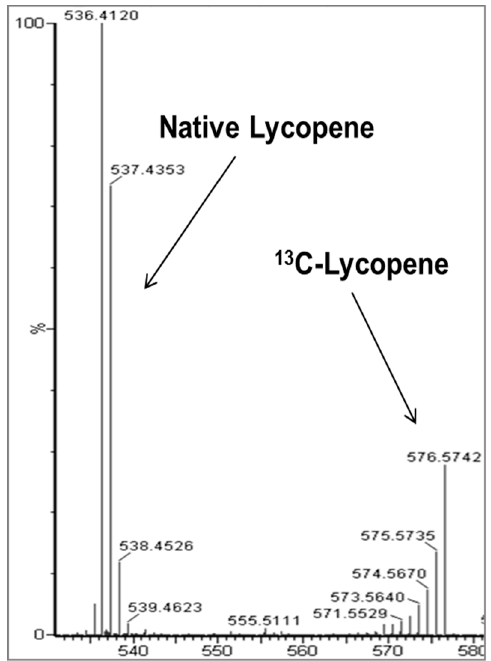
Figure 5. Mass spectrum comparing the isotope distributions for native (unlabeled) lycopene and the 13 C-labeled lycopene in a representative plasma sample.